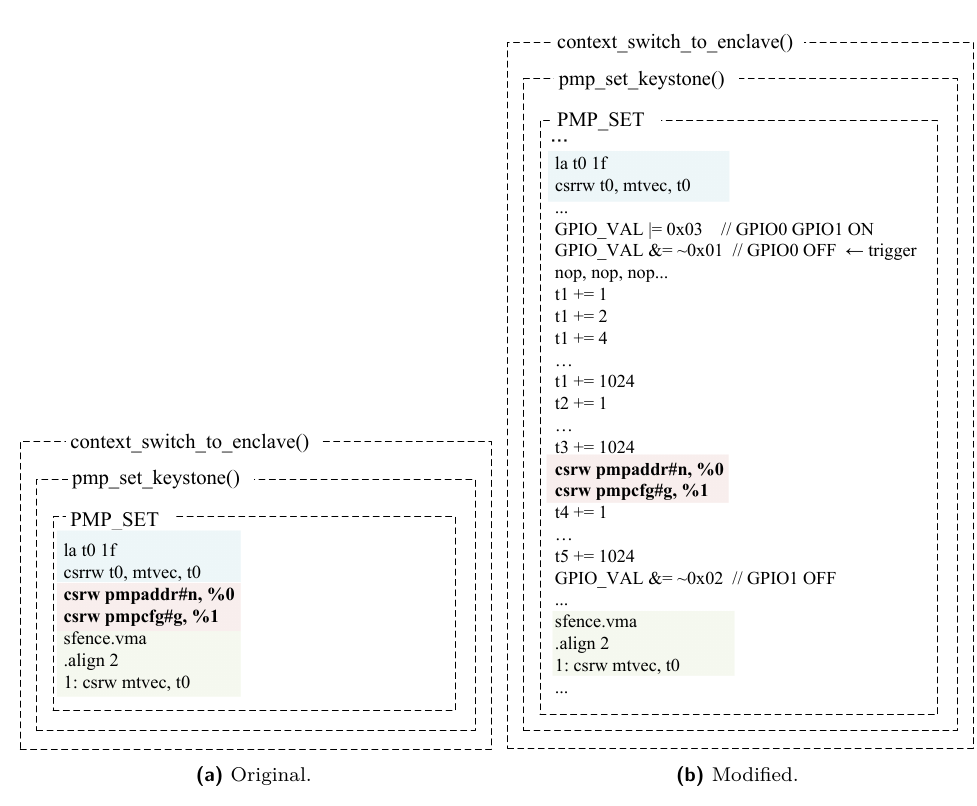
Figure 23: Target code for